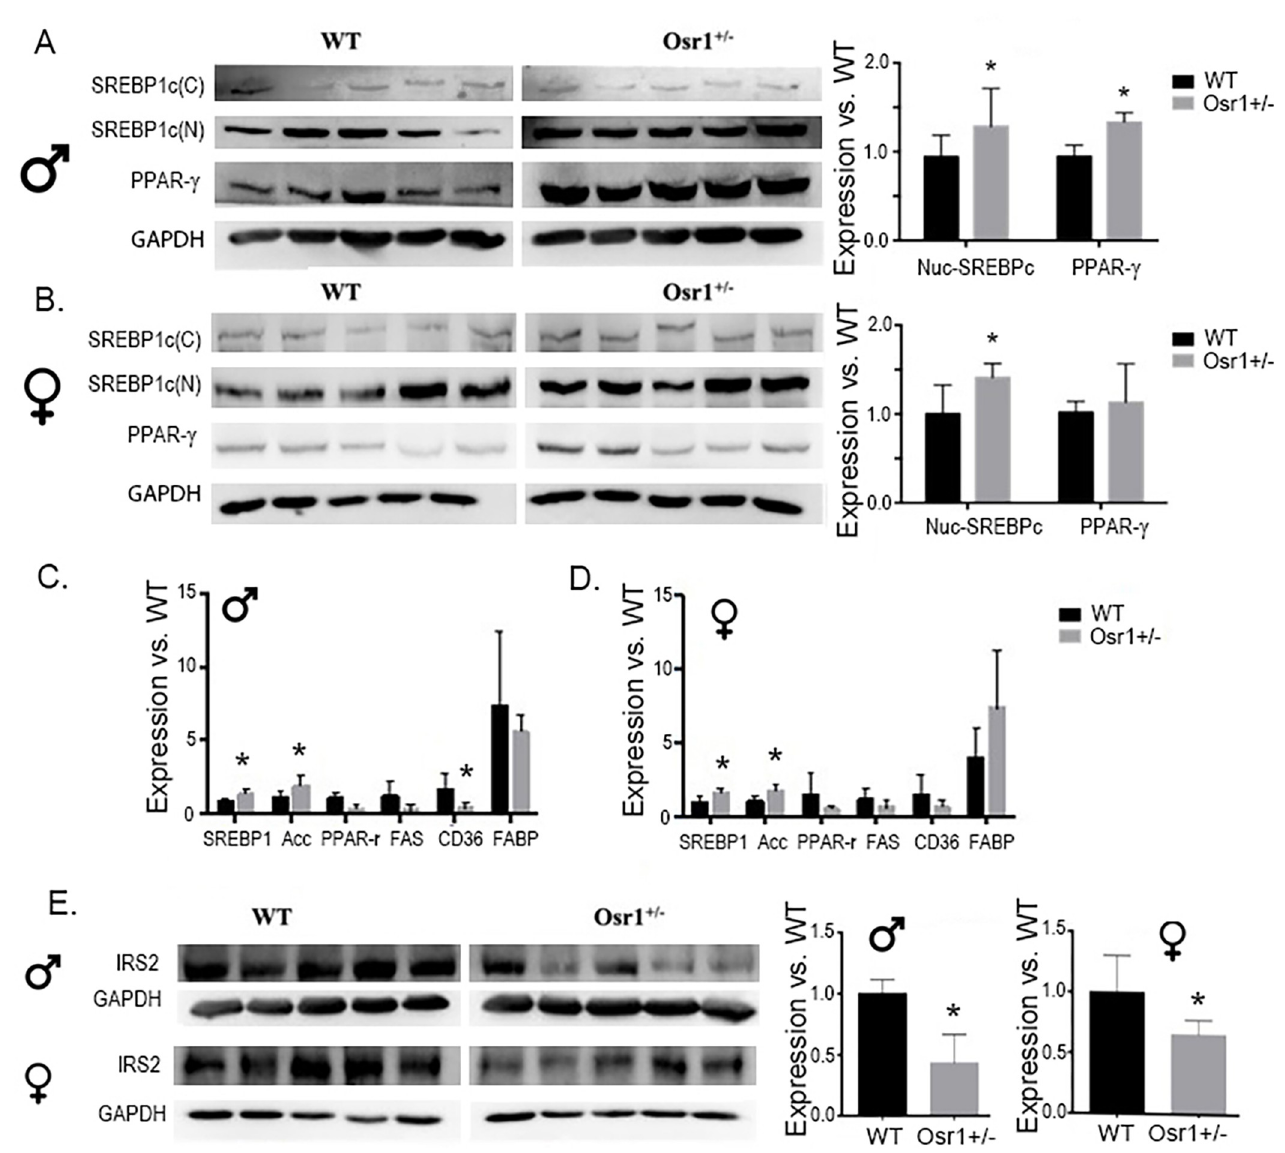
Fig 3. Osr1 heterozygous mice display hepatic overexpression of key modulators of lipogenesis. (A). The nuclear SREBP1c and PPAR- γ were significantly increased in male Osr1 mice compared to WT. (B). SREBP1 was significantly enhanced in Osr1 heterozygous female mice. (C). SREBP1 and ACC was significantly increased in Osr1 heterozygous male mice compared to wildtype. CD36 was significantly increased in WT mice. (D). SREBP1 and ACC was significantly increased in Osr1 heterozygous female mice compared to wildtype. (E). Both Osr1 +/- male and female mice exhibited significantly impaired IRS-2 expression compared to WT mice. Data is presented as Mean ± SD, N = 5; � p < 0.05.